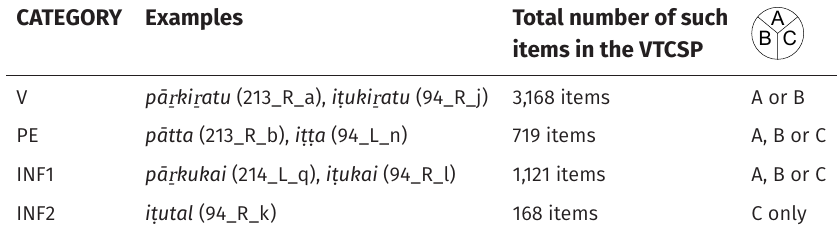
Table 3: Statistics concerning four of the possible values of the CATEGORY element in the